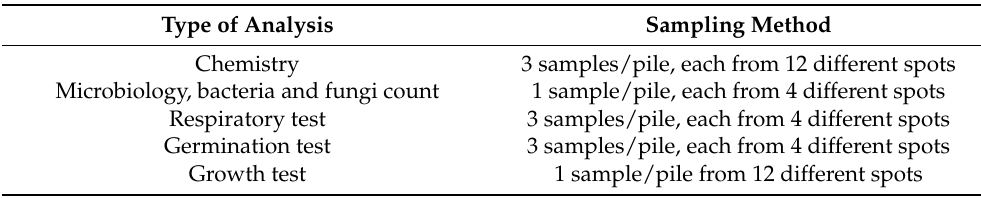
Table 2. The type of analysis and sampling method per compost